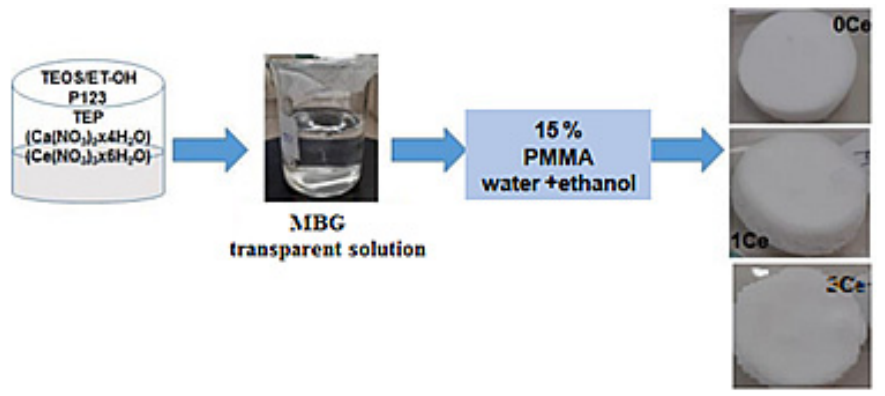
Figure 11. Composite scaffolds preparation chart.